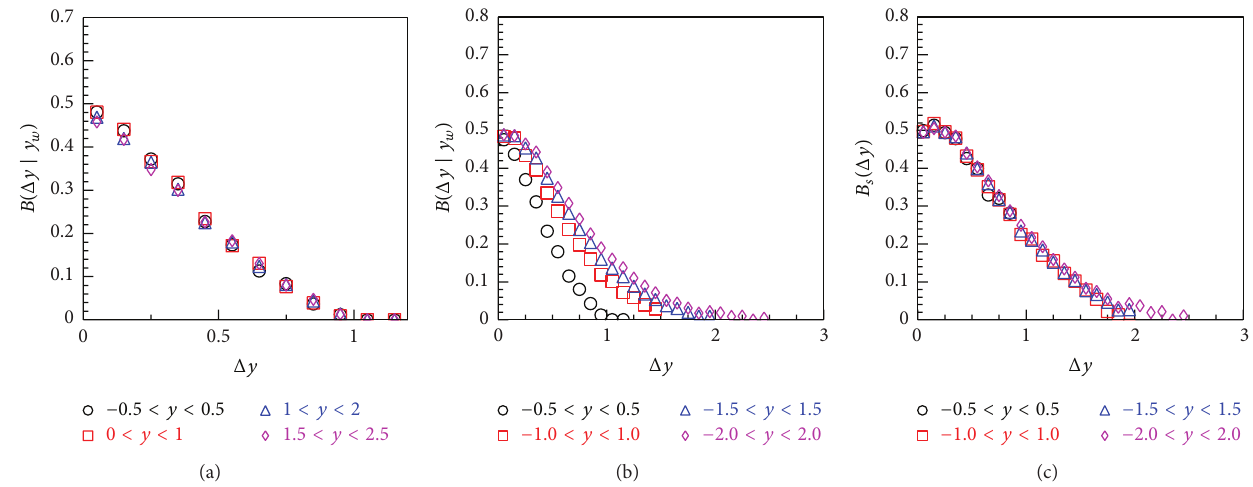
Figure 3: The 𝑝 𝑇 -integrated 𝐵(Δ𝑦 | 𝑦 𝑤 ) of final hadron system at different rapidity positions with same (a) and different (b) window sizes, as well as the 𝐵 𝑠 (Δ𝑦) (c). Correlation coefficient 𝜌 is taken to be 0.3. The graph is taken from [30].